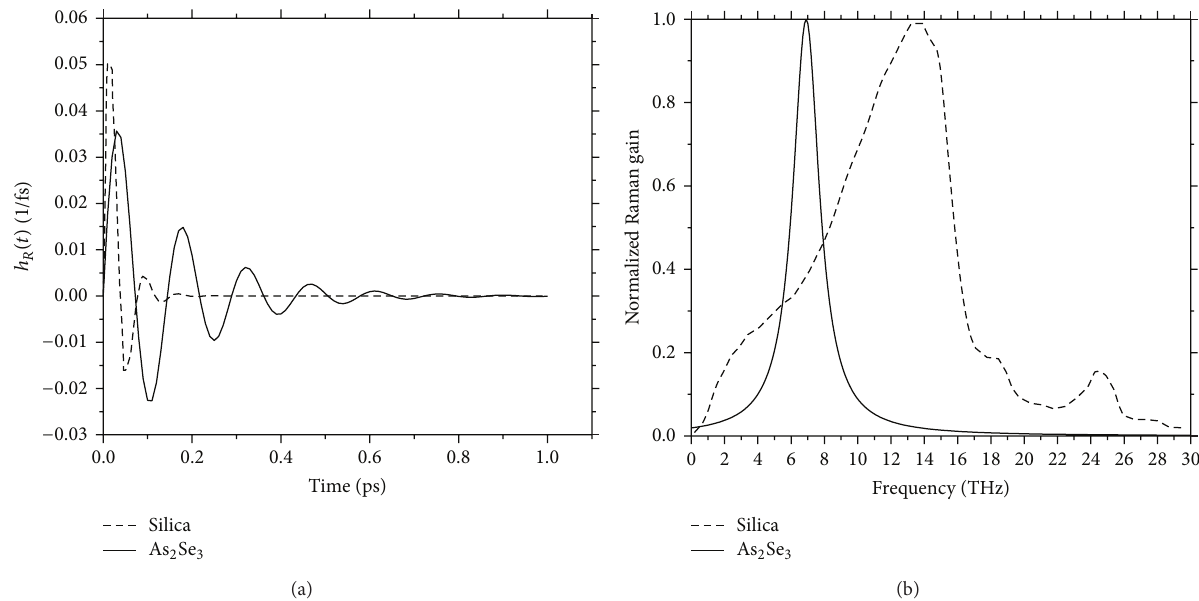
Figure 2: (a) Temporal Raman response functions calculated for both As 2 Se 3 chalcogenide (solid curve) and silica materials (dashed curve) and (b) the corresponding normalized Raman gains.